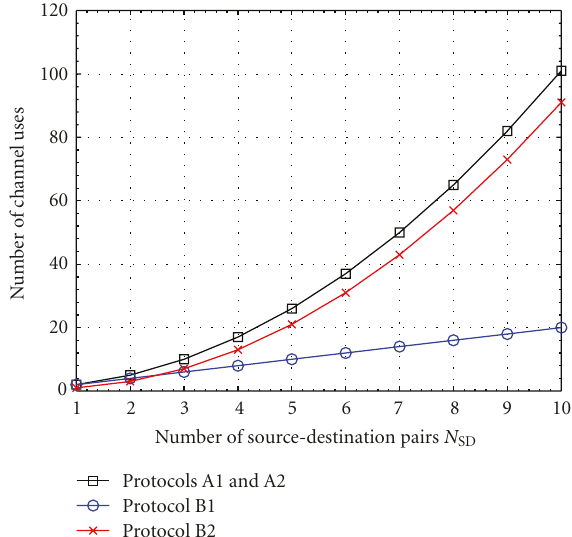
Figure 2: Number of channel uses required to estimate all channel coe ffi cients for the four protocols if N R = N 2